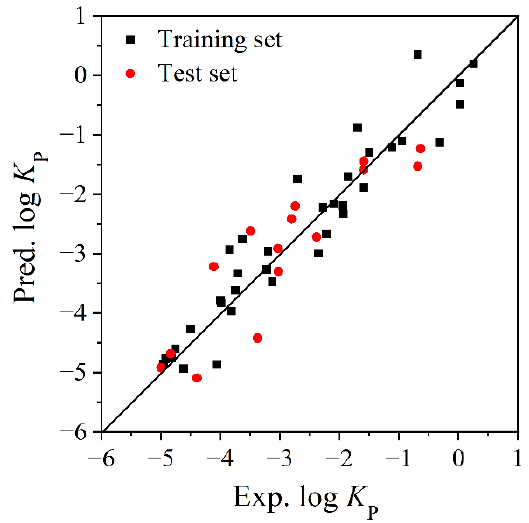
Figure 5. Fitting plot of experimental and predictive log K P values by SVM model. (4) Comparison of the different models